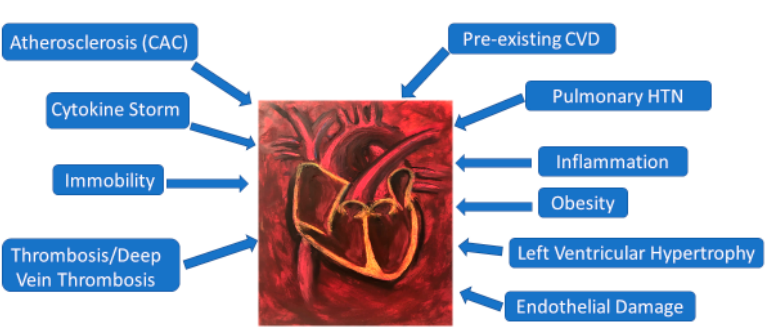
Figure 2. Factors contributing to cardiovascular damage in COVID-19. The white text in blue bubbles represents some of the pathologies that are associated with CVD in patients with COVID-19. Arrows are drawn from each factor to the central image of the heart and associated vasculature to emphasize their effect on the cardiovascular system specifically. CAC—Coronary Artery Calcium score; IL-6: interleukin-6; CVD: cardiovascular